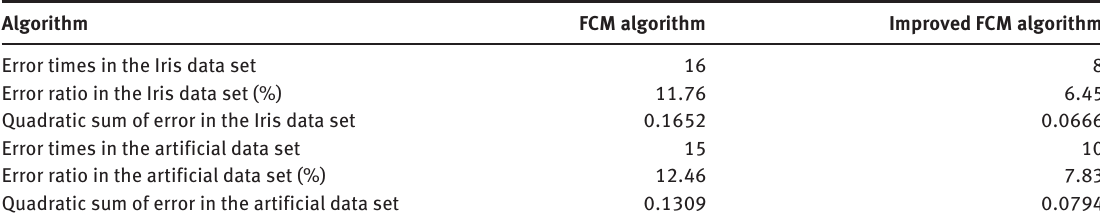
Table 3. Comparison of the Conventional and Improved FCM Algorithms.